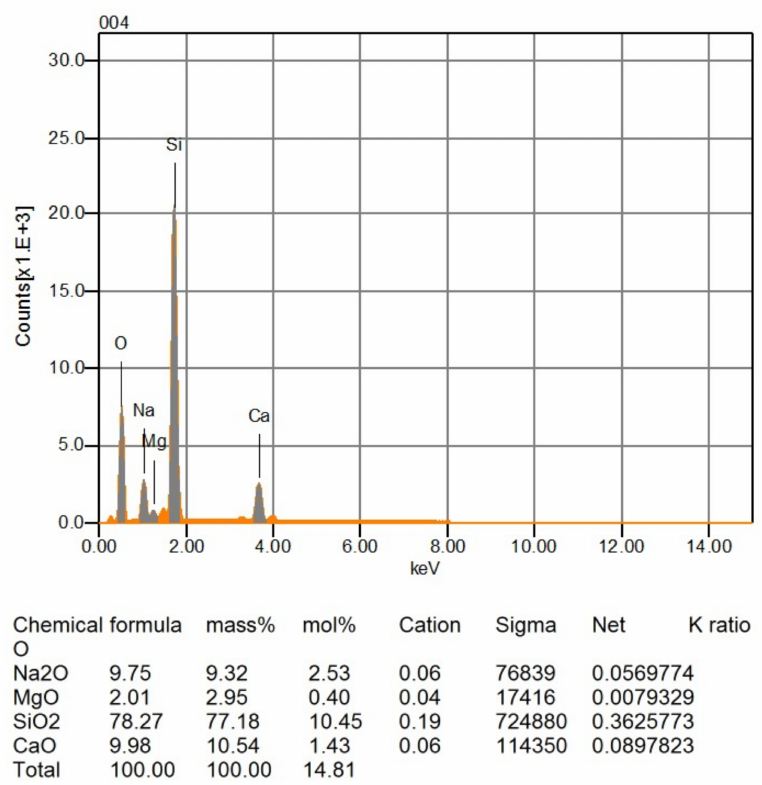
Figure 7. Energy-dispersive spectroscopy (EDS) semi-quantitative analysis showing glass sand composition consistent with soda lime